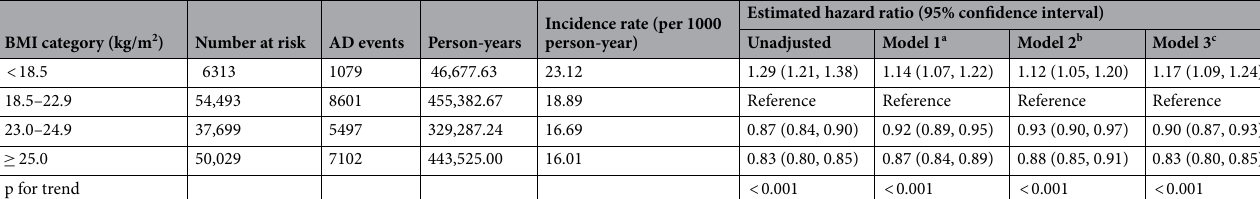
< 0.001 < 0.001 < 0.001 < Table 2. The incidence and risk of Alzheimer’s dementia by BMI category. BMI, body mass index; AD, Alzheimer’s dementia. a Adjusted for age and sex. b Adjusted for variables in model 1 and smoking, alcohol consumption, regular exercise, and low-income status. c Adjusted for variables in model 2 and hypertension, diabetes mellitus, dyslipidemia, and cardiovascular disease.